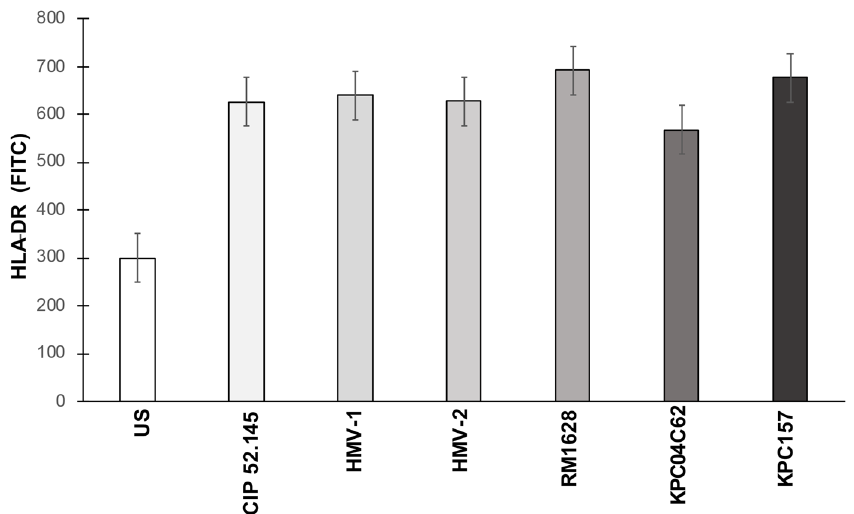
Figure 1. Maturation of DCs induced by K. pneumoniae strains. DCs were cultured with medium alone (unstimulated, US) or with live bacterial cells. Data were collected with a cytofluorimeter and are expressed as median fluorescence intensity (± IQR ×1.5) of three different experiments. The maturation level of each sample was compared (with the exception of US) and no significant statistical differences were